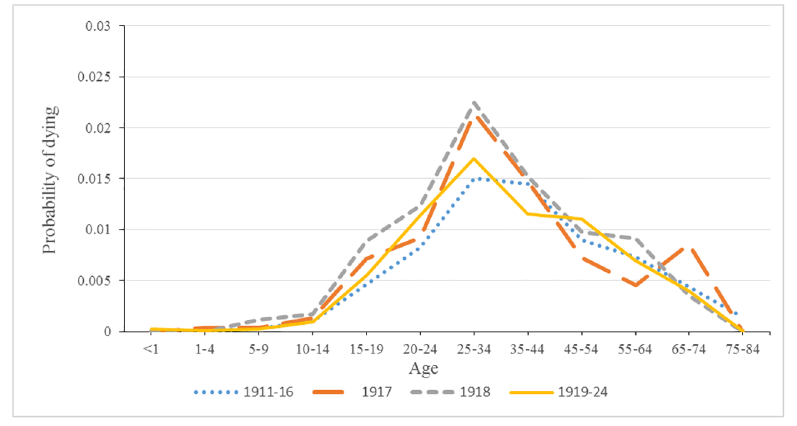
Fig 4. Male probability of dying from tuberculosis for four time periods.